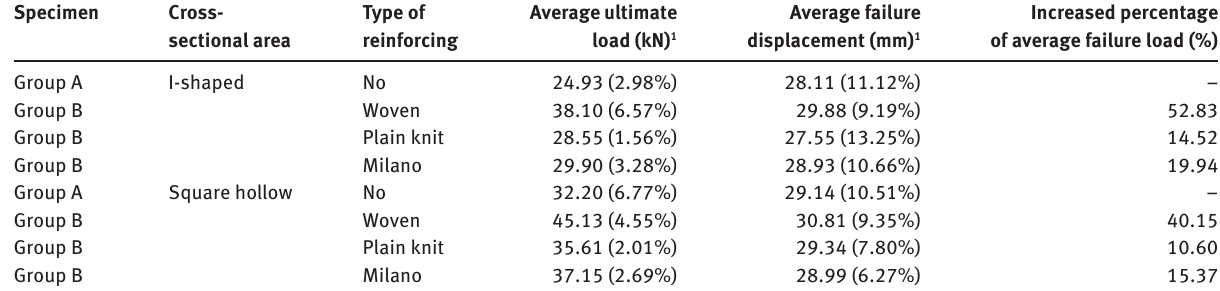
Table 5 Results summary of bending tests. 1 The values in parentheses ( ) represent the coefficient of